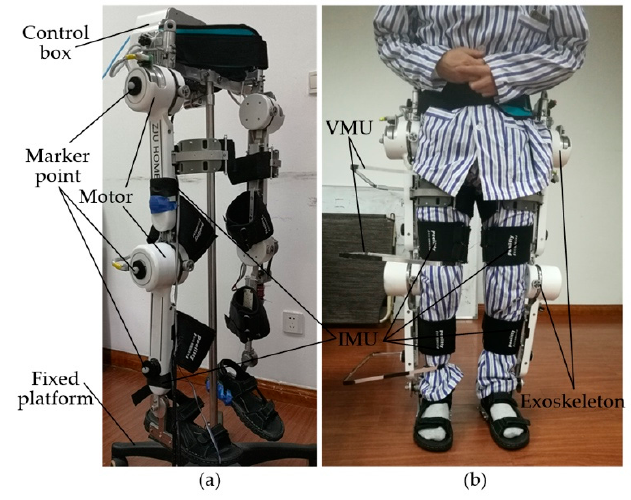
Figure 13. Exoskeleton without load ( a ) and human with exoskeleton ( b ).